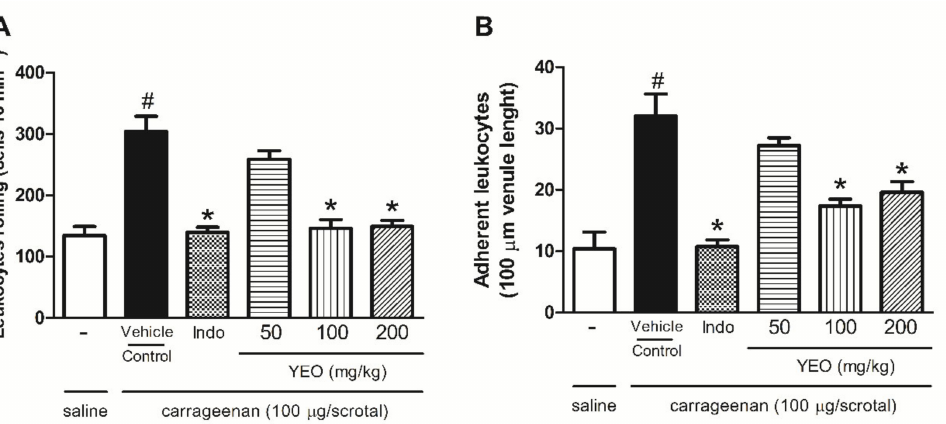
Figure 4. Effect of YEO on leukocyte rolling ( A ) and adhesion ( B ) in the in situ microcirculation test. Wistar rats were pretreated with YEO, indomethacin, or the vehicle. After 1 h, saline or carrageenan was injected into the scrotum. The leukocyte behavior was evaluated by intravital microscopy in the spermatic fascia 2 h after the carrageenan injection. # p < 0.05 versus saline. * p < 0.05 versus the control group (ANOVA, Newman–Keuls